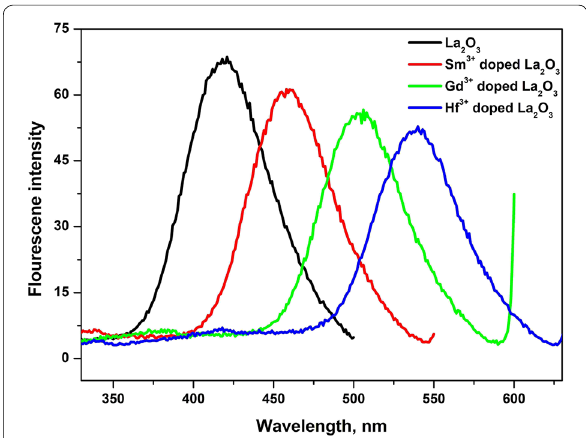
Fig. 2 Room temperature optical PL spectrum of undoped and doped La 2 O 3 nanoparticles Fig. 3 FTIR spectrum of the doped and undoped La